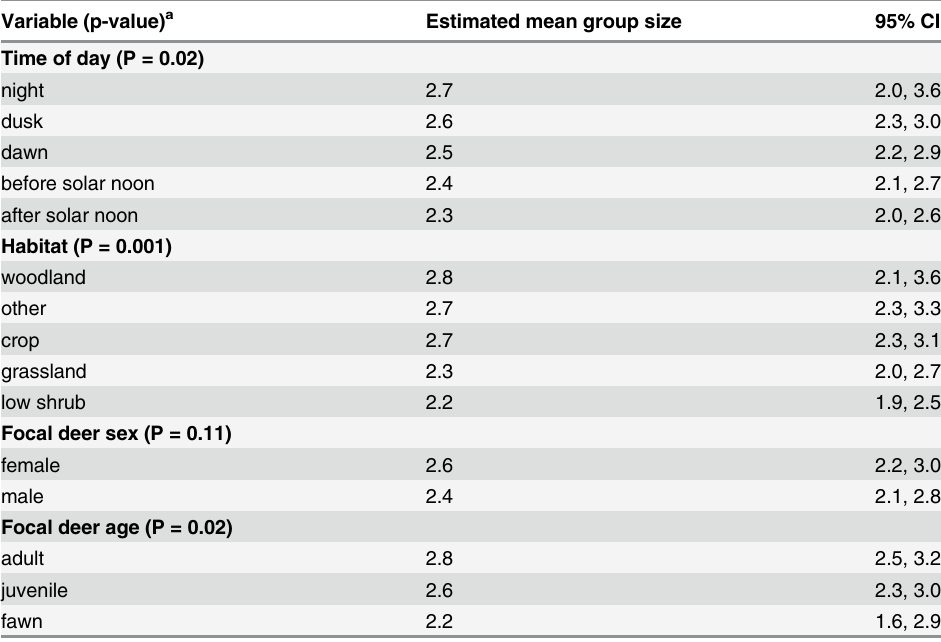
Table 4. Least squares means for predicted mean group size according to time of day, habitat, sex of focal deer, and age of focal deer. Variable (p-value) a Estimated mean group size 95% CI Time of day (P =